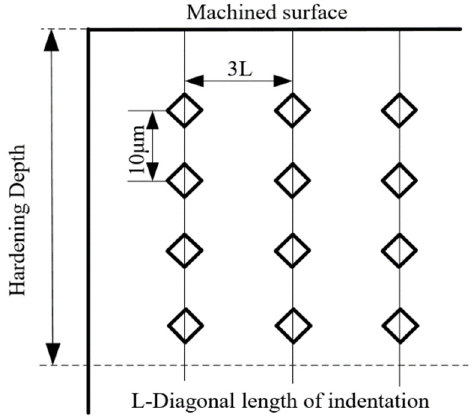
Figure 16. Hardness measurement schematic diagram.